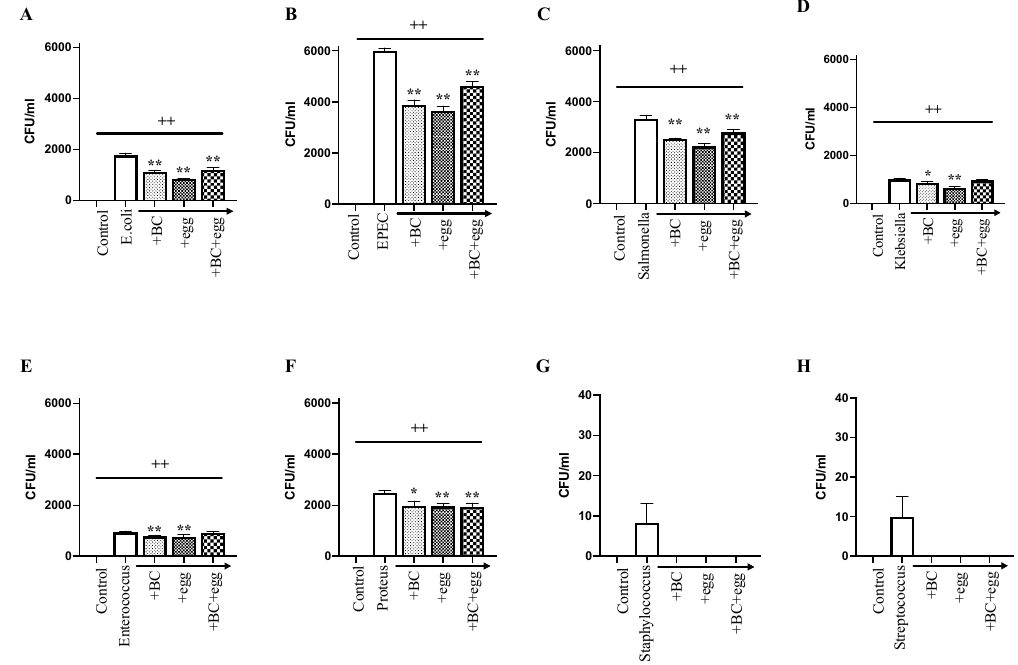
Figure 1. Effect of bovine colostrum (BC), egg, or the combination on transepithelial passage of bacteria. Bacterial strains (1 × 10 6 colony-forming units (CFU)/well) ± BC (1 mg/mL), egg (1 mg/mL), or the combination (0.6 mg/mL BC + 0.4 mg/mL egg) were added to the apical side of confluent monolayers of Caco-2 cells grown in transwell plates. The medium was collected from the basal side, 24 h later, and assessed for the number of colony-forming units (CFU)/mL. Control wells received no bacteria or test product. ( A ) Escherichia coli ATCC 25922 O6; ( B ) enteropathogenic E. coli (EPEC); ( C ) Salmonella ; ( D ) Klebsiella ; ( E ) Enterococcus ; ( F ) Proteus ; ( G ) Staphylococcus ; ( H ) Streptococcus. Note that the scale of the y -axis of results for Staphylococcus and Streptococcus are lower than for other strains. Results are expressed as mean ± SEM for 6 wells. ++ signifies p < 0.01 vs. non treated (without bacteria or test product) control, * and ** signify p < 0.05 and 0.01 vs. bacteria alone. The nonpathogenic and noninvasive E. coli K12 did not result in any CFUs in this experiment, and therefore is not